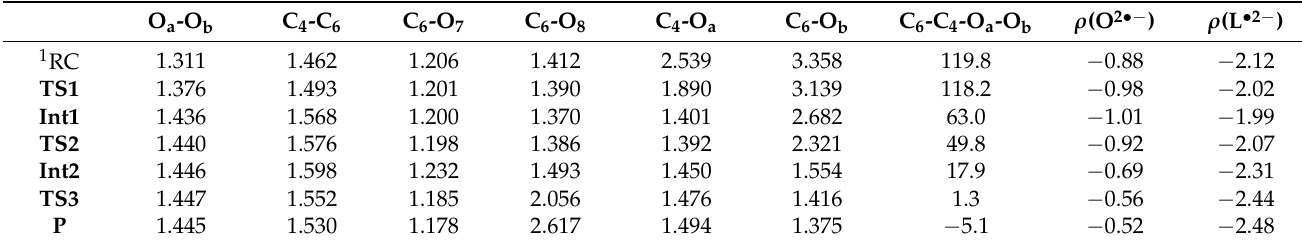
Table 1. The key geometric parameters (in Å and degrees) and the Mulliken charges population on L • 2 − and O 2 • − of the stationary points of L 3 − oxygenation by ONIOM method (UM06-2X/MM). (See atomic labels in Figure